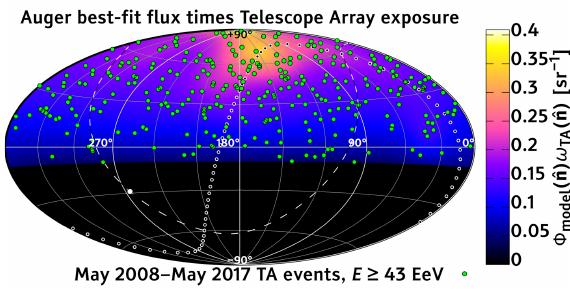
Figure 3. The events in the dataset we used and its directional exposure, multiplied by the model flux.